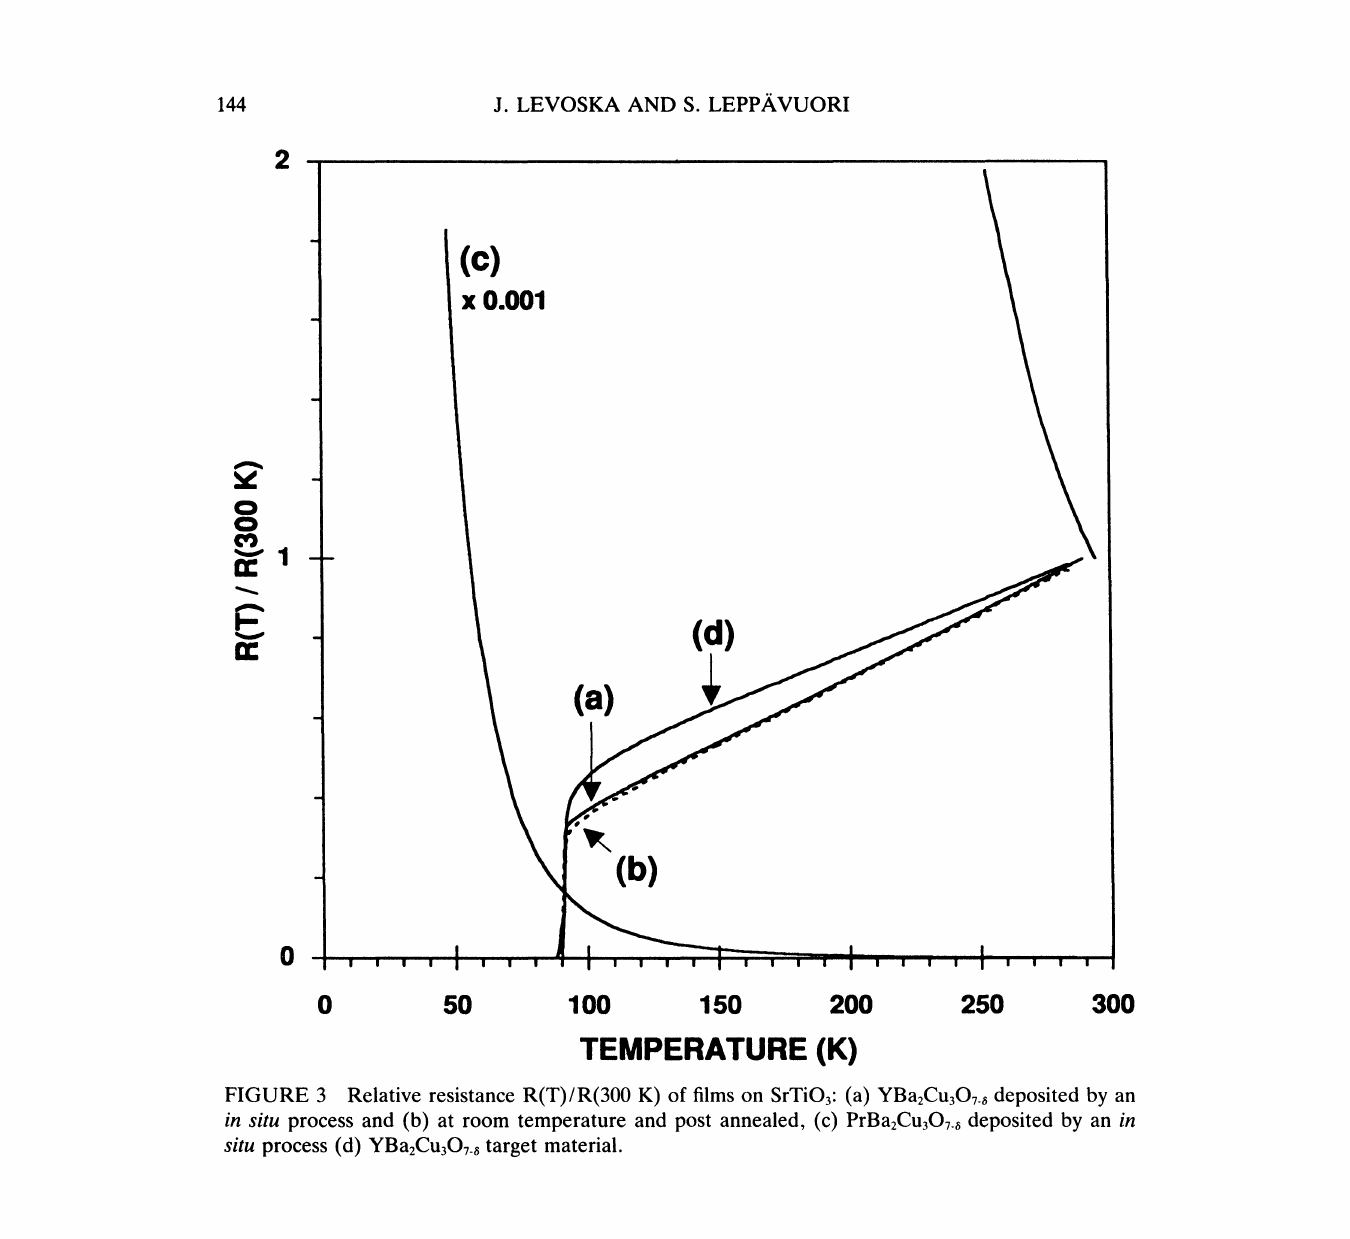
FIGURE 3 Relative resistance R(T)/R(300 K) of films on SrTiO3: (a) YBa2Cu3OT. deposited by an in situ process and (b) at room temperature and post annealed, (c) PrBa2Cu3OT. deposited by an in situ process (d) YBa2Cu3OT_ target